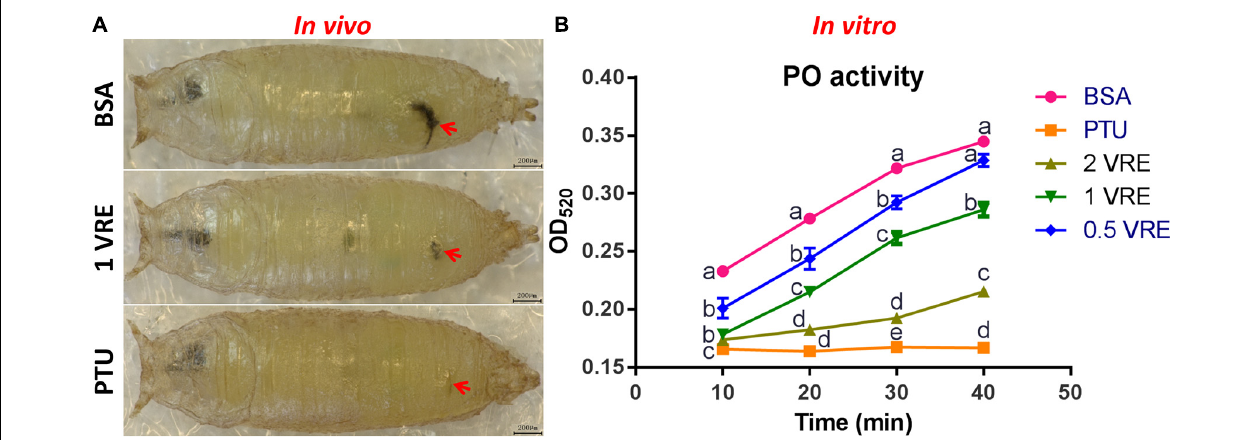
FIGURE 3 | Effects of venom on melaninization of the host hemolymph. (A) Microscope inspection of w 1118 pupae was performed 3 h after injection with BSA, 1 VRE, or PTU. (B) PO activity was assayed every 10 min by measuring the OD 520 after hemolymph was co-incubated with BSA, PTU, or VRE. The results are shown as the mean ± standard error ( n = 3); different lowercase letters above bars for the same time point indicate significant difference ( P <